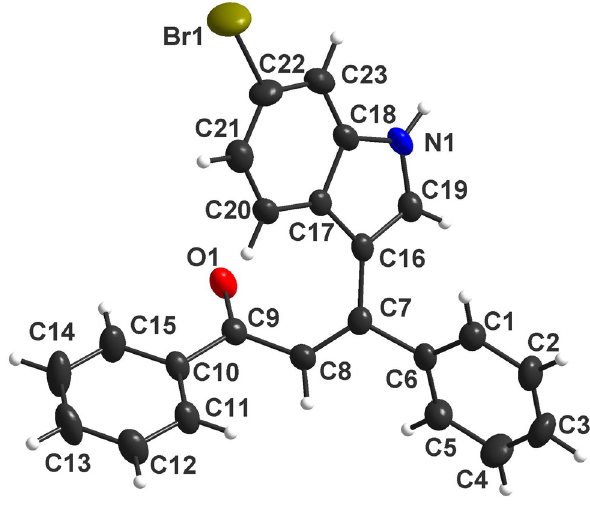
Table  : Data collection and handling.